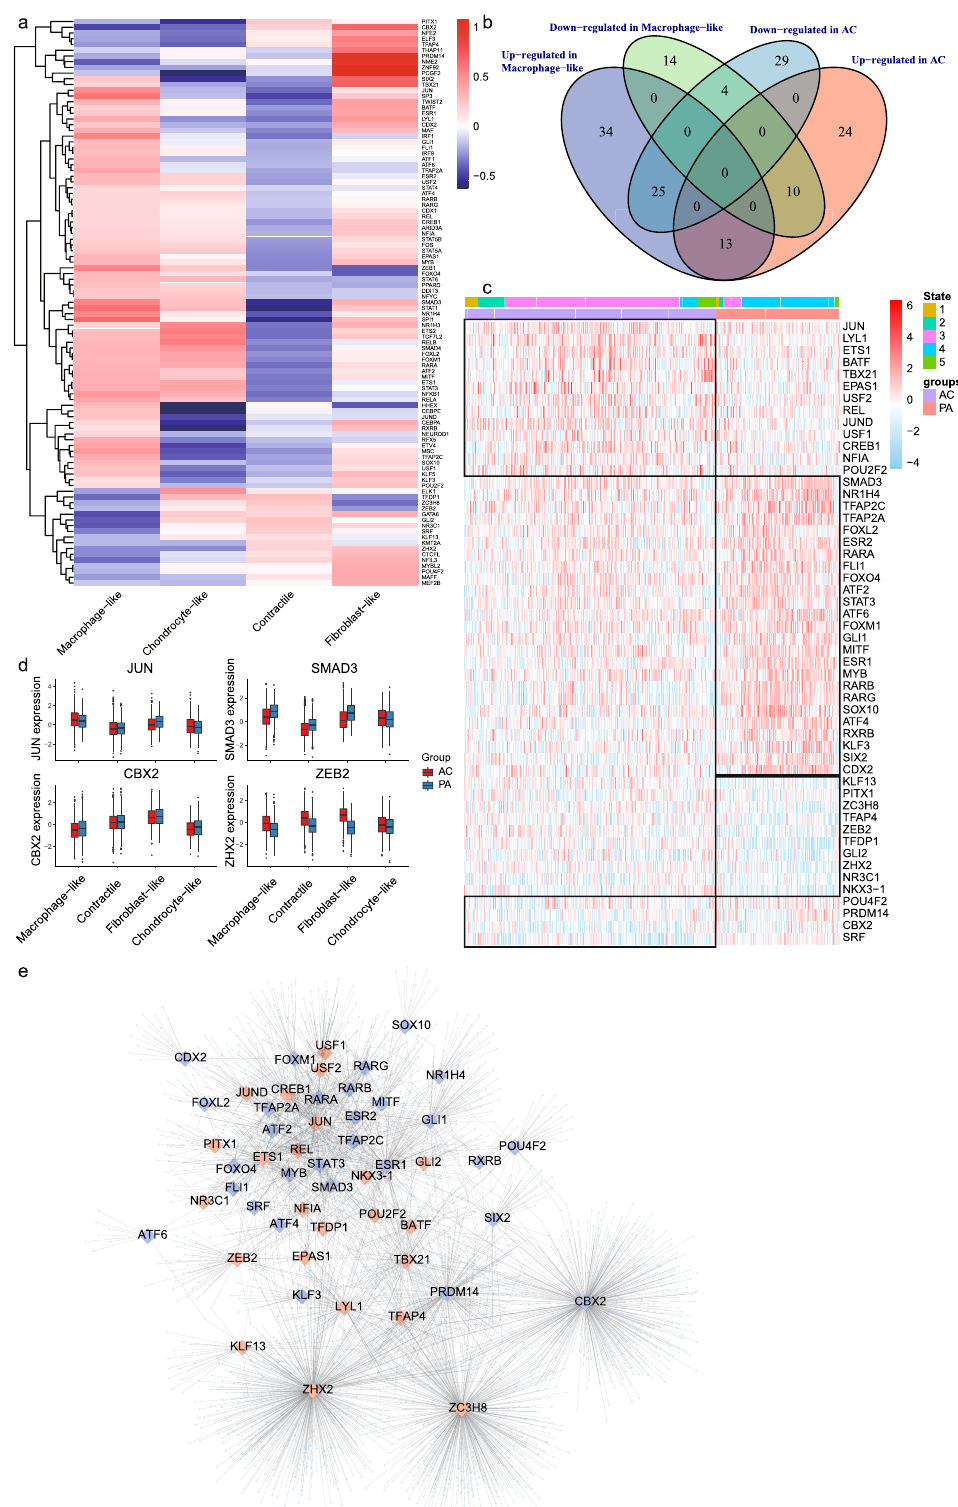
IL-1 β induces downregulation of STAT3 during atherosclerosis progression by in vivo tests . The increase of IL-1 β in aorta at 16 weeks of HFD feeding can be reversed by injection of AAV-sgIL- 1 β (Supplementary Fig. 11a, b). Compared with mice fed by HFD for 8 weeks, the lower expressions of p-STAT3 and α -SMA and higher expressions of CD68 were found in the aorta